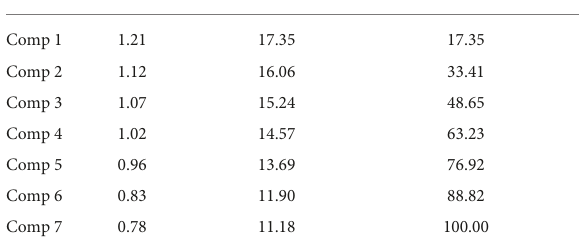
TABLE 9 Coordinates of a principal components analysis in